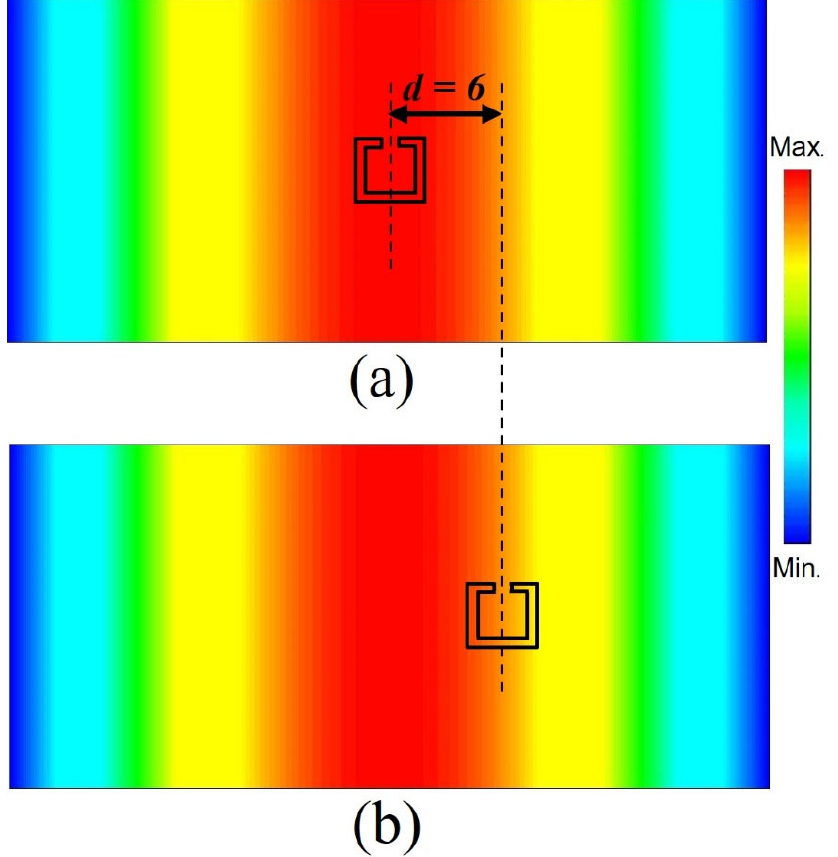
Figure 3. Distribution of the waveguide port electric field mapped with the ( a ) symmetric and ( b ) asymmetric configurations of the designed structures.